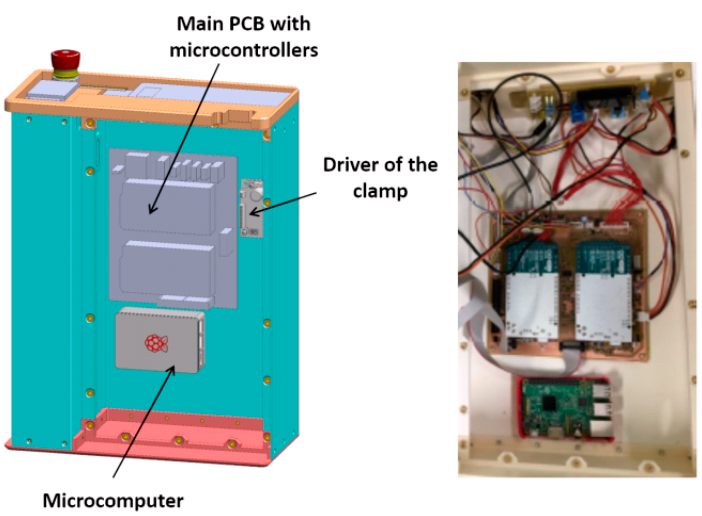
Figure 2. Internal panel with the main electronic components of the RAP: 3D sketch and manufactured